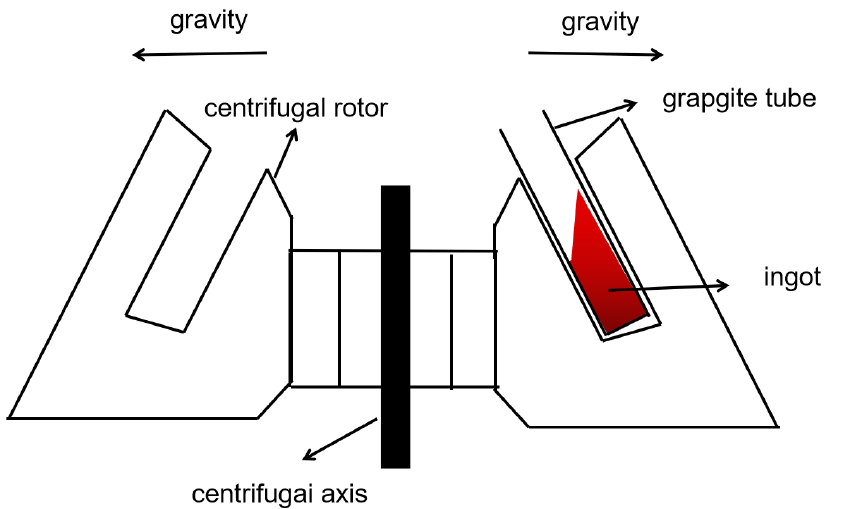
Figure 1. Schematic diagram of the centrifugal apparatus.